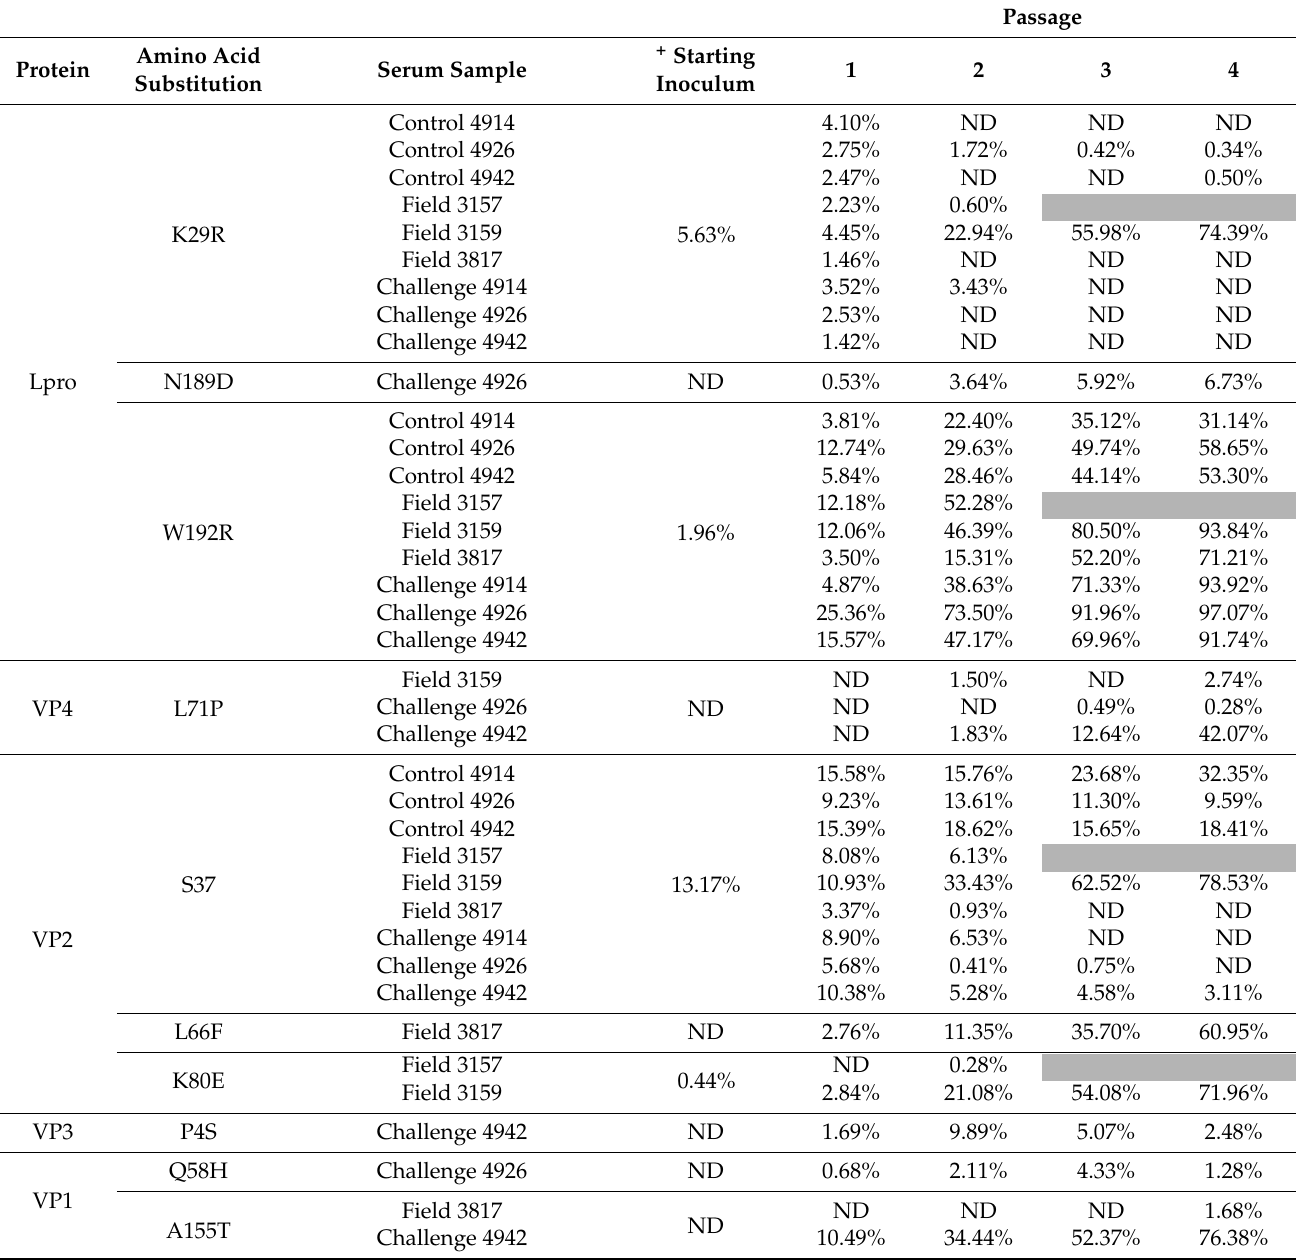
Table 1. Accumulation of nucleotide substitutions which were either specific to treatment with FMDV sub-neutralising sera or increased upon passage in the presence of sub-neutralising sera, which, once detected, persisted in all subsequent passages